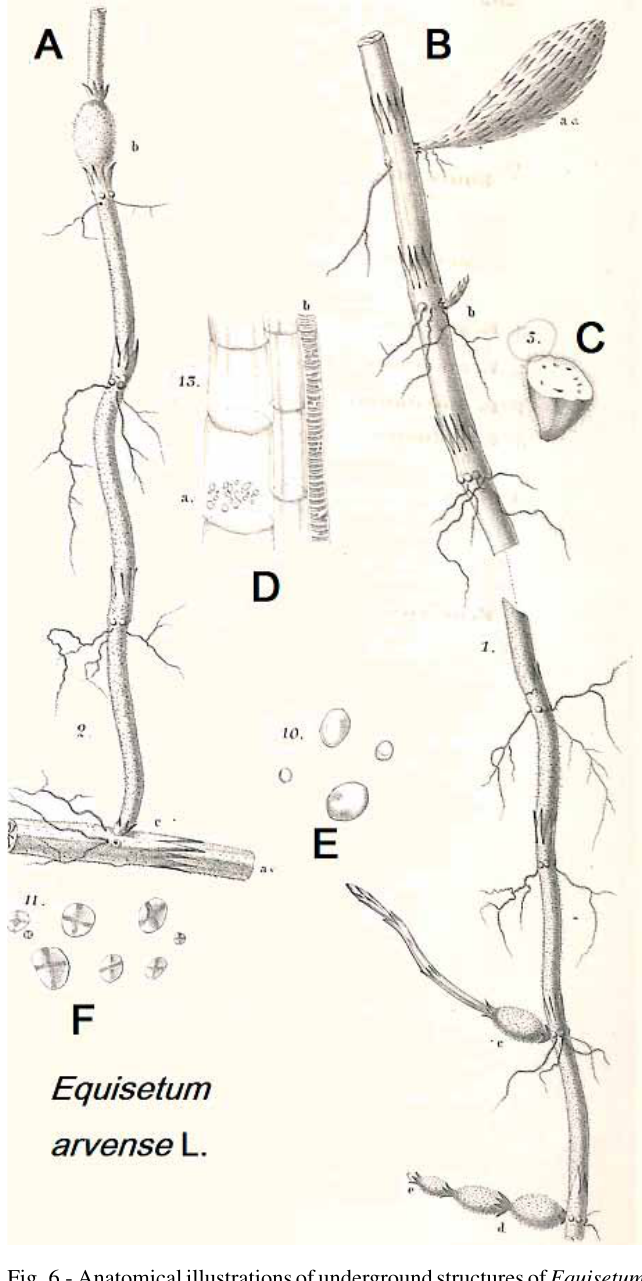
Fig. 6 - Anatomical illustrations of underground structures of Equisetum arvense L. found in a classical book by J. Duval-Jouve (1864). (A) Horizontal rhizomes. (B) Vertical rhizomes. (C) Section of large tuber attached to rhizome. (D) Cells of a tuber with starch granules (left) and vessel (right). (E, F) Starch granules. This book was originally collected and preserved through collabora- tive research between Université Paris Diderot and The Univer- sity of Kitakyushu (Kawano and Bouteau, 2007; Kawano et al ., 2008). Original images were digitally scanned and slightly modified (illustrations of other plant species were